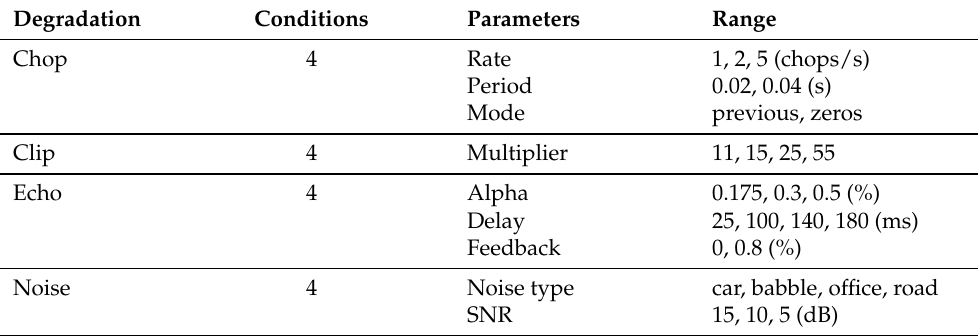
Table 5. Audio Degradations